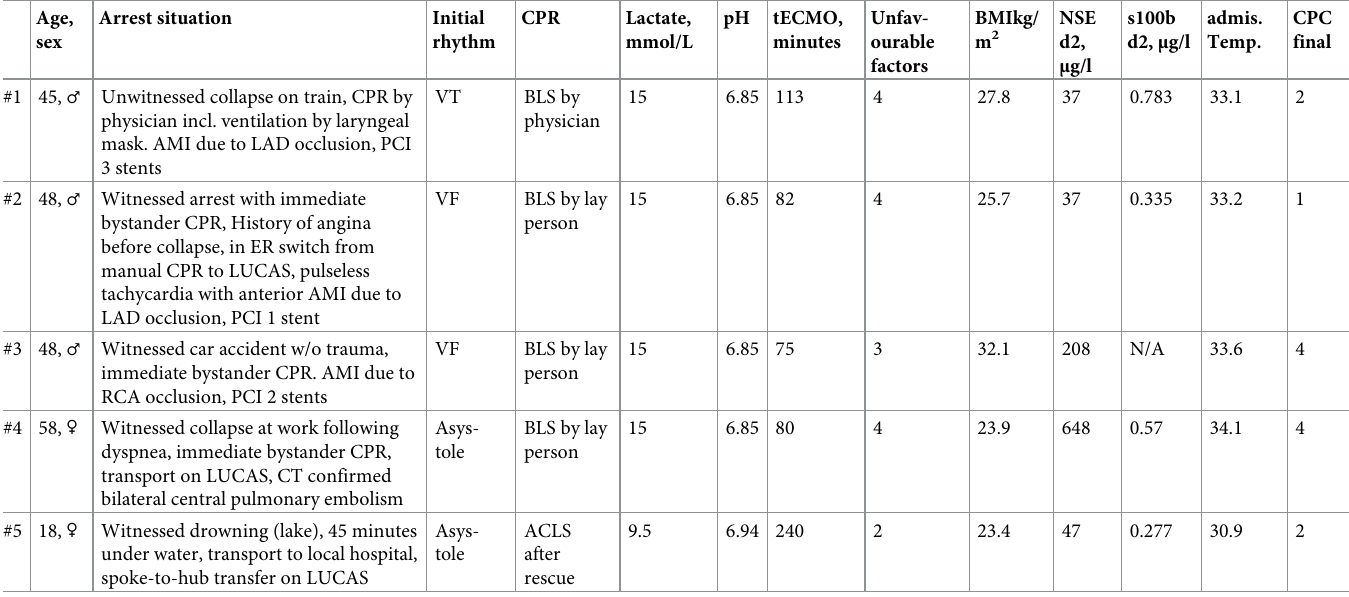
not been as predictive as they might have lost predictive value due to a rather long time-to- ECMO, which could be a surrogate for prolonged low-flow times. This again emphasises the critical role of improving preclinical management of eCPR candidates, and future eCPR pro- grams need to shorten the low-flow-time to a minimum.